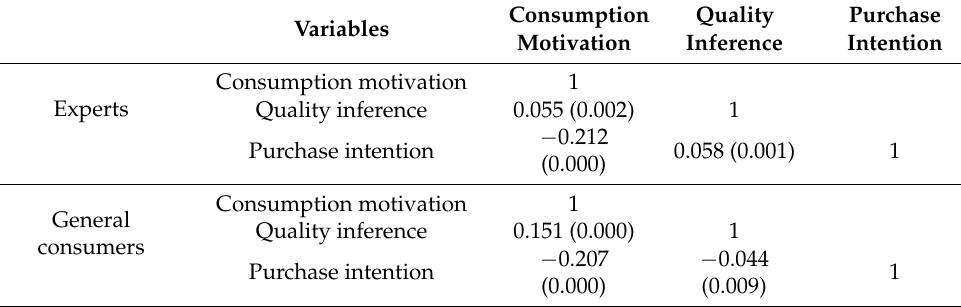
Table 9. Results of the correlation analysis between the main